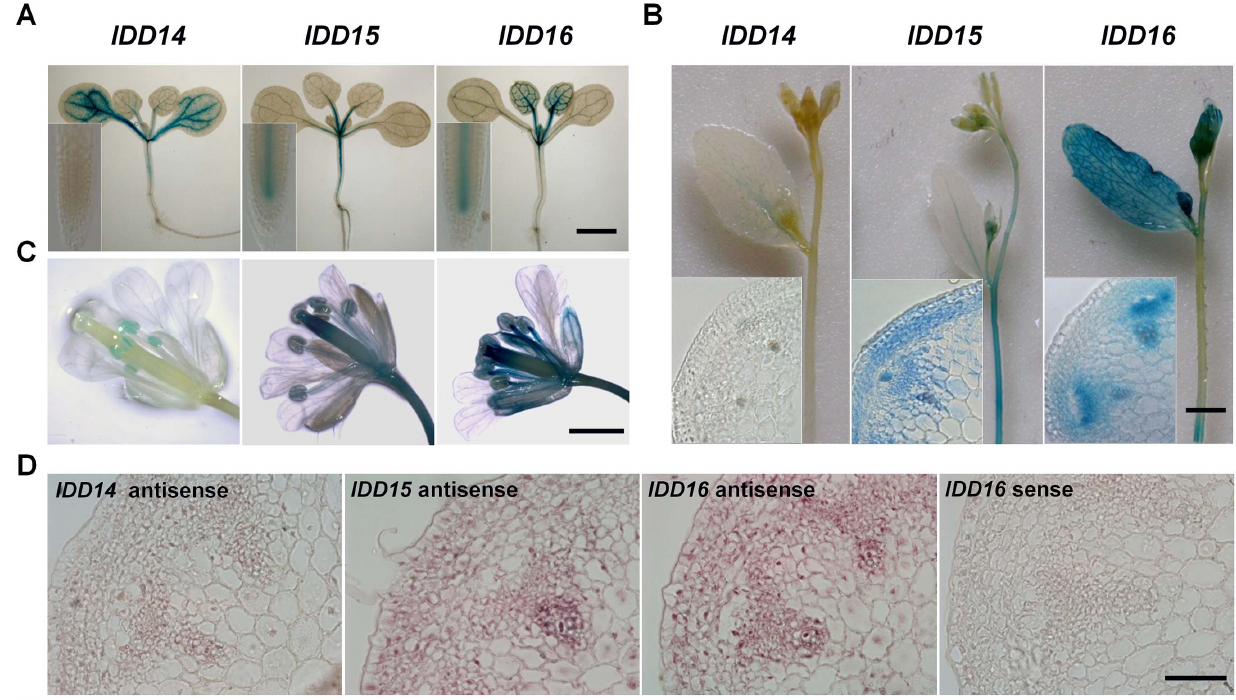
Figure 3. Differential and overlapping expression of IDD14 , IDD15 , and IDD16 . (A) Expression of IDD14 , IDD15 , and IDD16 in seedlings assayed by GUS staining. The 12-day-old transgenic seedlings carrying pIDD14::GUS , pIDD15::GUS , or pIDD16::GUS constructs were subjected to GUS staining assays. Insets show the primary roots. The scale bar represents 1 mm. (B) GUS staining of the florescence stems of pIDD14::GUS , pIDD15::GUS , and pIDD16::GUS transgenic plants. Insets show the transverse sections of inflorescence stems. The scale bar represents 2 mm. (C) GUS staining of the floral organs of pIDD14::GUS , pIDD15::GUS , and pIDD16::GUS transgenic plants. The scale bar represents 1 mm. (D) Expression of IDD14 , IDD15 , and IDD16 in inflorescence stems assayed by RNA in situ hybridization. A section hybridized with an IDD16 sense probe is shown as a control. The scale bar represents 50 m m.